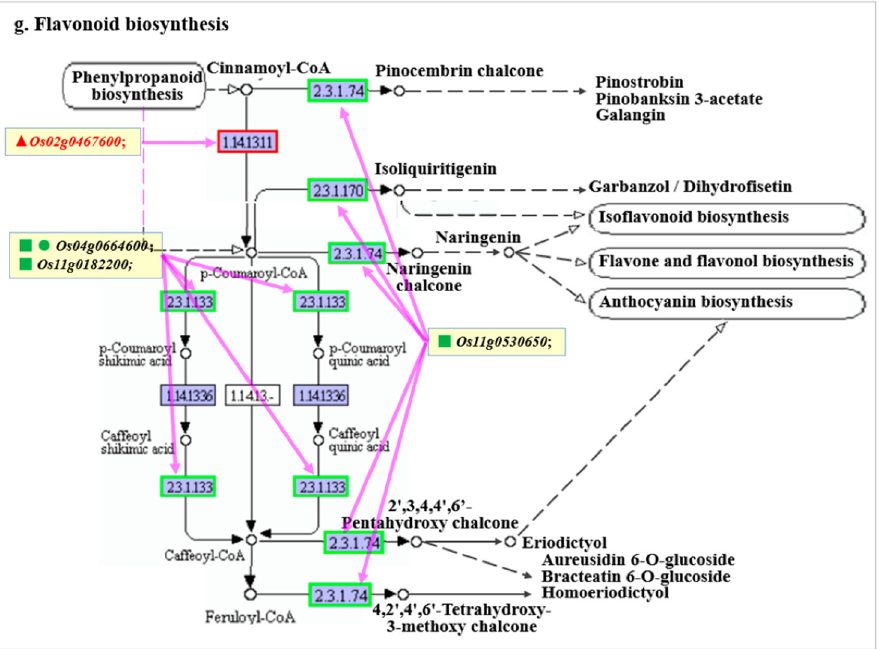
Figure 5. WT-vs-MT: Important KEGG pathways related to plant disease resistance mechanism. ( a ) Plant-pathogen interaction pathway; ( b ) Plant hormone signal transduction pathway; ( c ) MAPK signaling pathway-plant pathway; ( d ) α -Linolenic acid metabolism pathway; ( e ) Phenylpropanoid biosynthesis pathway; ( f ) Diterpenoid biosynthesis pathway; ( g ) Flavonoid biosynthesis pathway. ■ : 12 hpi; ▲ : 24 hpi; ● : 48 hpi; Green: down-regulated; Red: up-regulated.